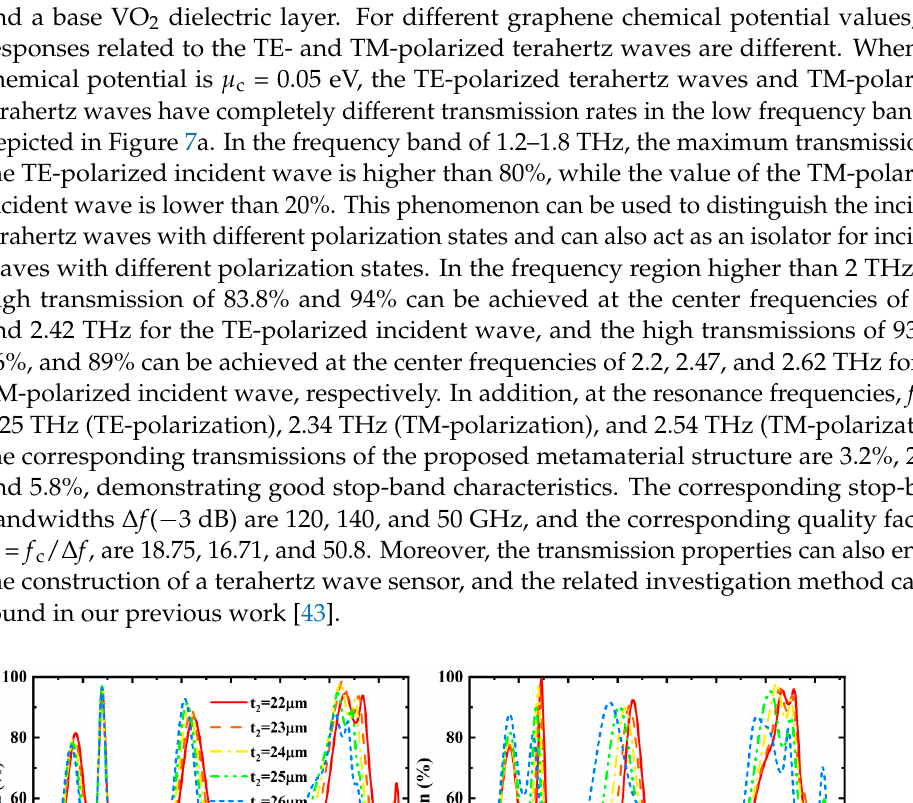
= 3 × 10 5 S/m and µ c = 1.2 eV, respectively.